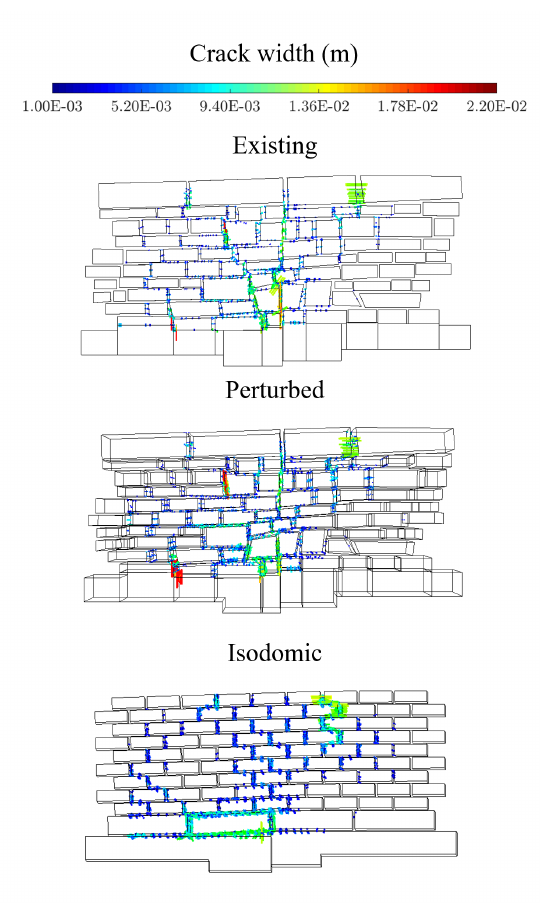
Figure 8. Results of simulation for existing, perturbed, and isodomic